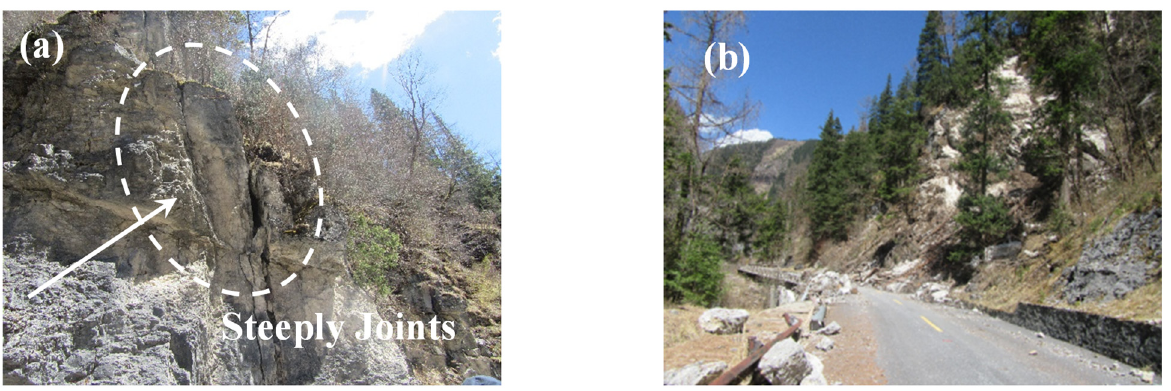
Figure 2. The high-steep slope ( a ) and the general view of the high-steep rock slide on the right bank Figure 2. The high ‐ steep slope ( a ) and the general view of the high ‐ steep rock slide on the right bank of the Swan-sea central highway ( b ). of the Swan ‐ sea central highway ( b ).